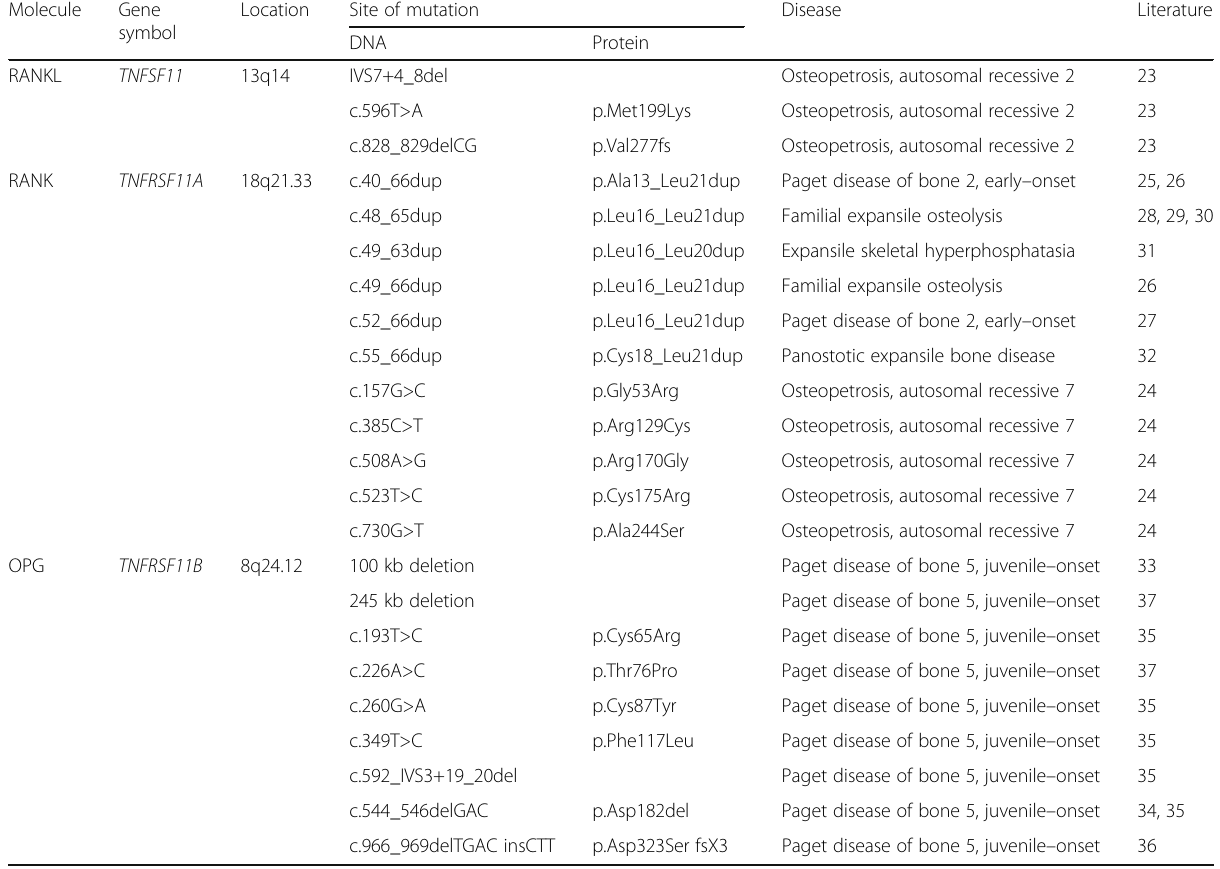
Table 1 Mutations of RANKL/RANK/OPG genes in hereditary bone diseases